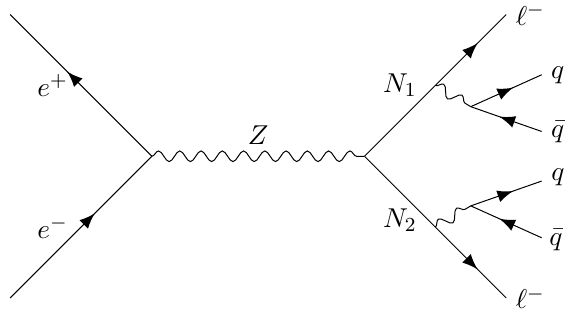
Figure 10 . Feynman diagram for 2 ‘ 4 q production in the SS leptons final state through s-channel Z